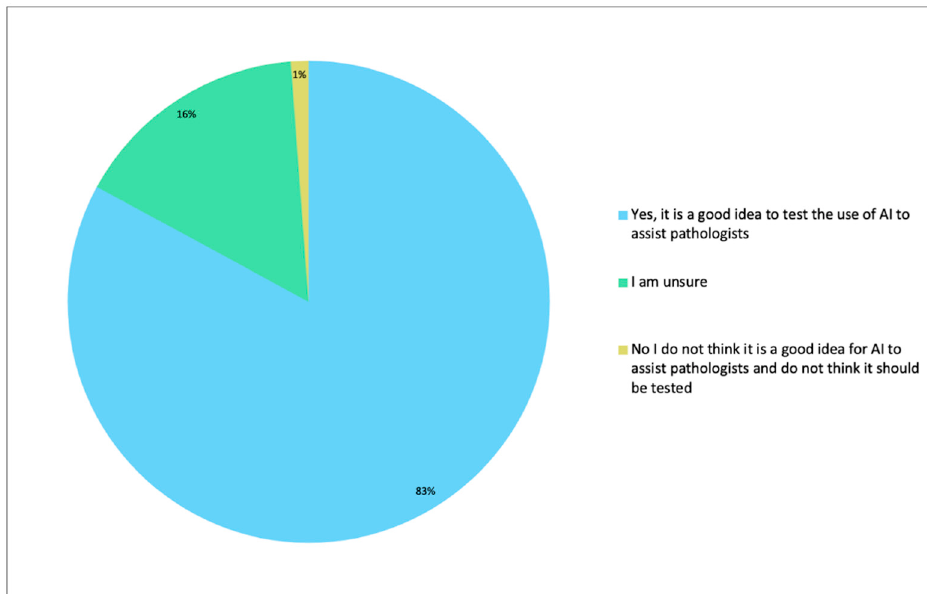
Figure 4. Digital developments could allow Artificial intelligence (AI) to be used in histopathology.